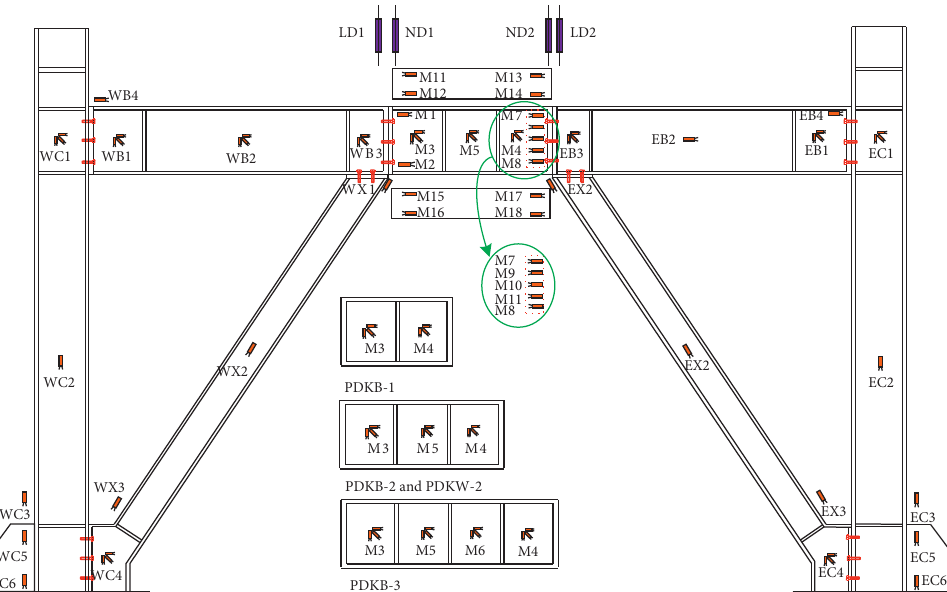
Figure 9: Arrangement of strain gauges and displacement meters.